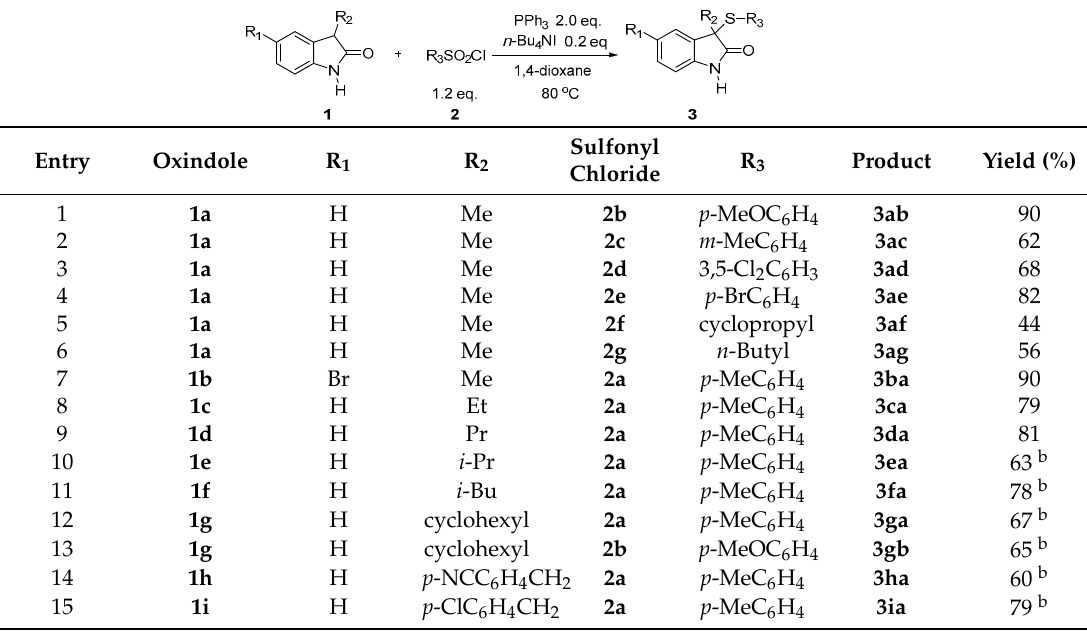
Table 2. Thiolation of 3-alkyloxindoles with sulfonyl chlorides in the presence of PPh 3 . a